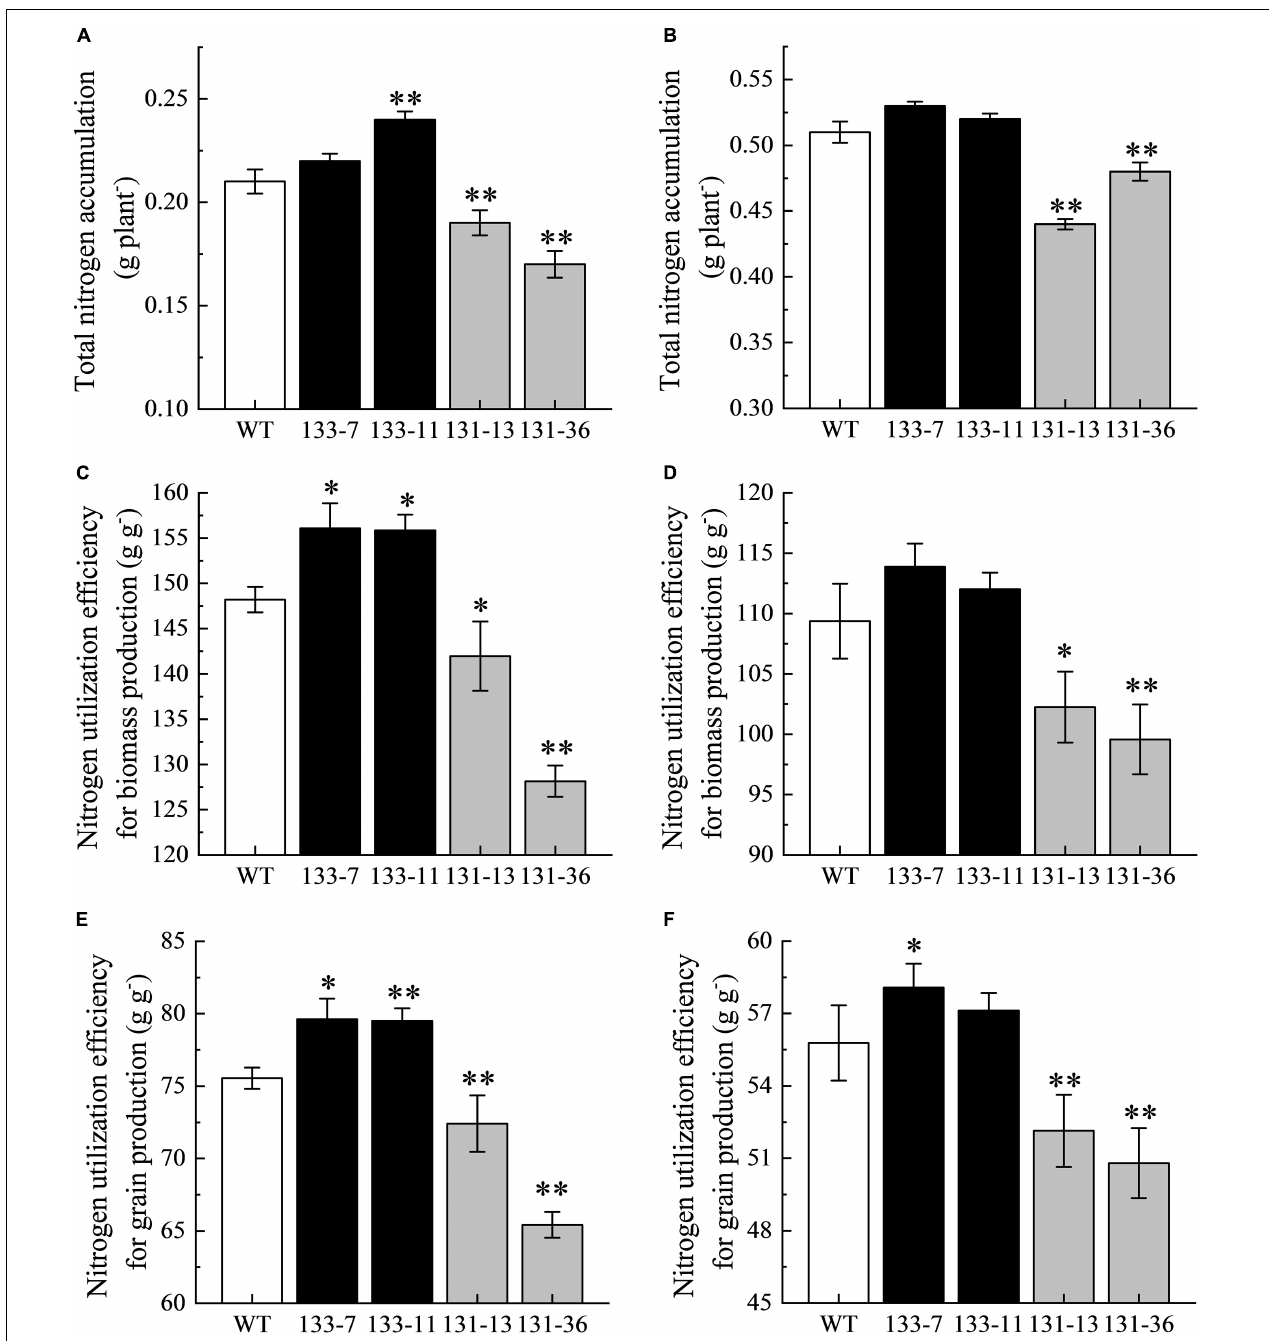
FIGURE 5 | Evaluation of total nitrogen accumulation (TNA), nitrogen utilization efficiency for biomass production (NUpE), and nitrogen utilization efficiency for grain production (NUgE) in transgenic rice. (A,B) TNA under DN and SN conditions. (C,D) NUpE under DN and SN conditions. (E,F) NUgE under DN and SN conditions. Values are mean ± SD ( n = 5), ∗ P < 0.05, ∗∗ P < 0.01 ( t